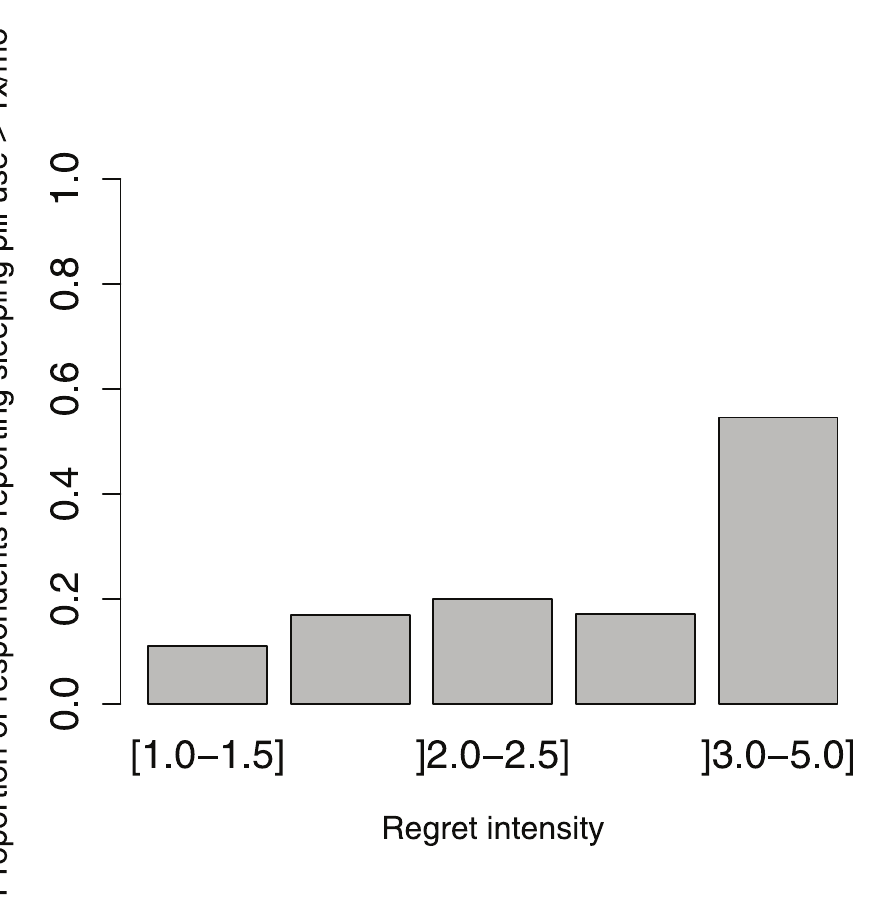
Fig 1. Proportion of respondents who reported using sleeping pills more than once a month according to levels of regret intensity (RIS – 10). Levels of regret intensity were aggregated if there were fewer than 10